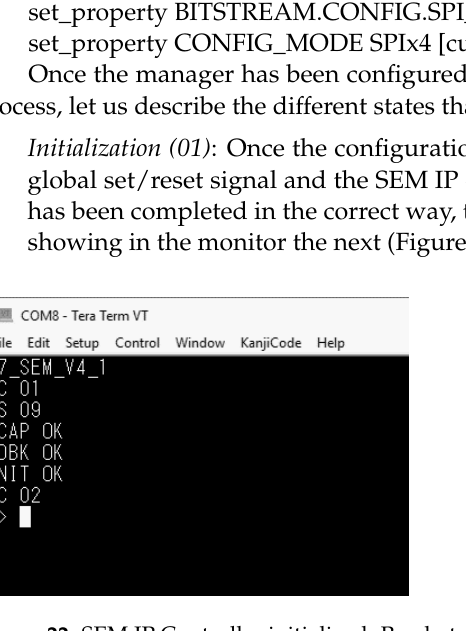
Figure 22. SEM IP Controller initialized. Ready to receive commands for the injection process.